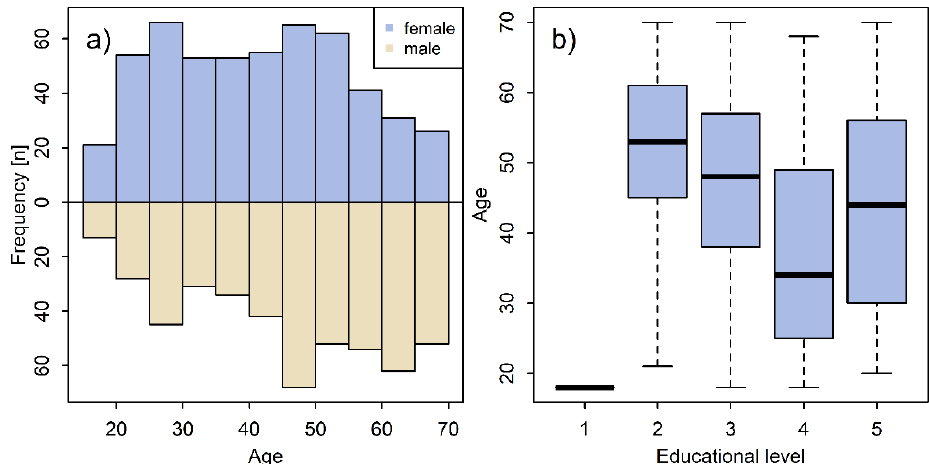
Figure 3. ( a ) Frequency of respondents age for female and male respondents. ( b ) Boxplot of respondents age per educational level (1: no educational degree, 2: elementary school, 3: lower sec- ondary school, 4: higher secondary school, 5: university degree).